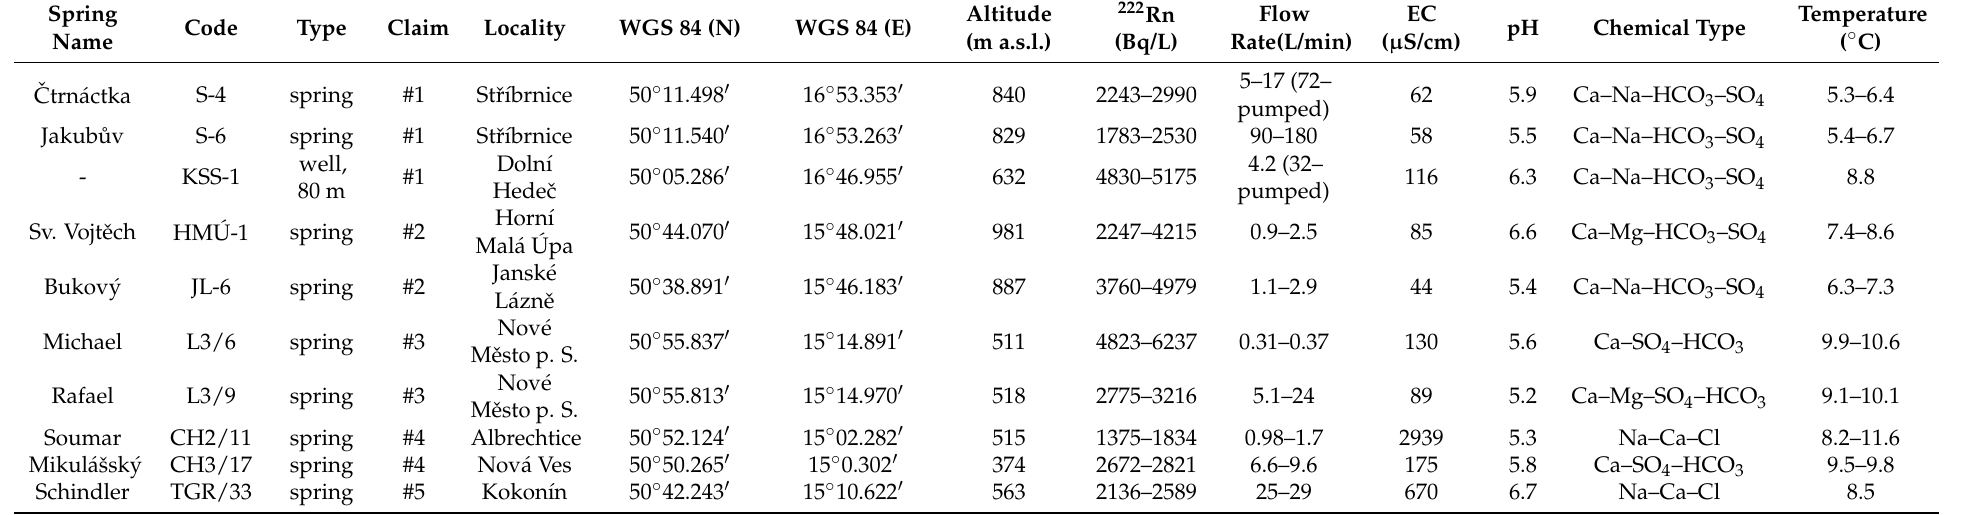
Table 2. Basic characteristics and parameters of the ten most important sources of radioactive mineral waters in the Lugian